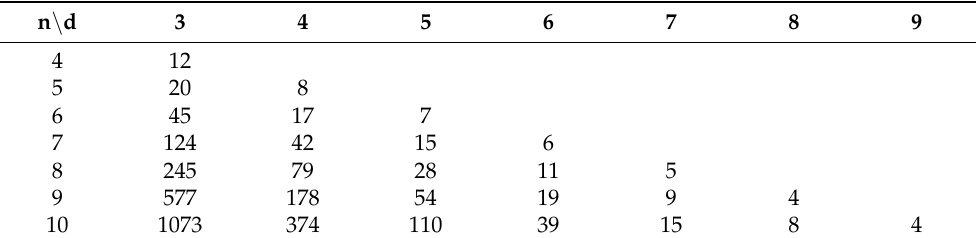
Table 7. Lower bounds for A GC , NL , DM , EP ( n , d ) . n \